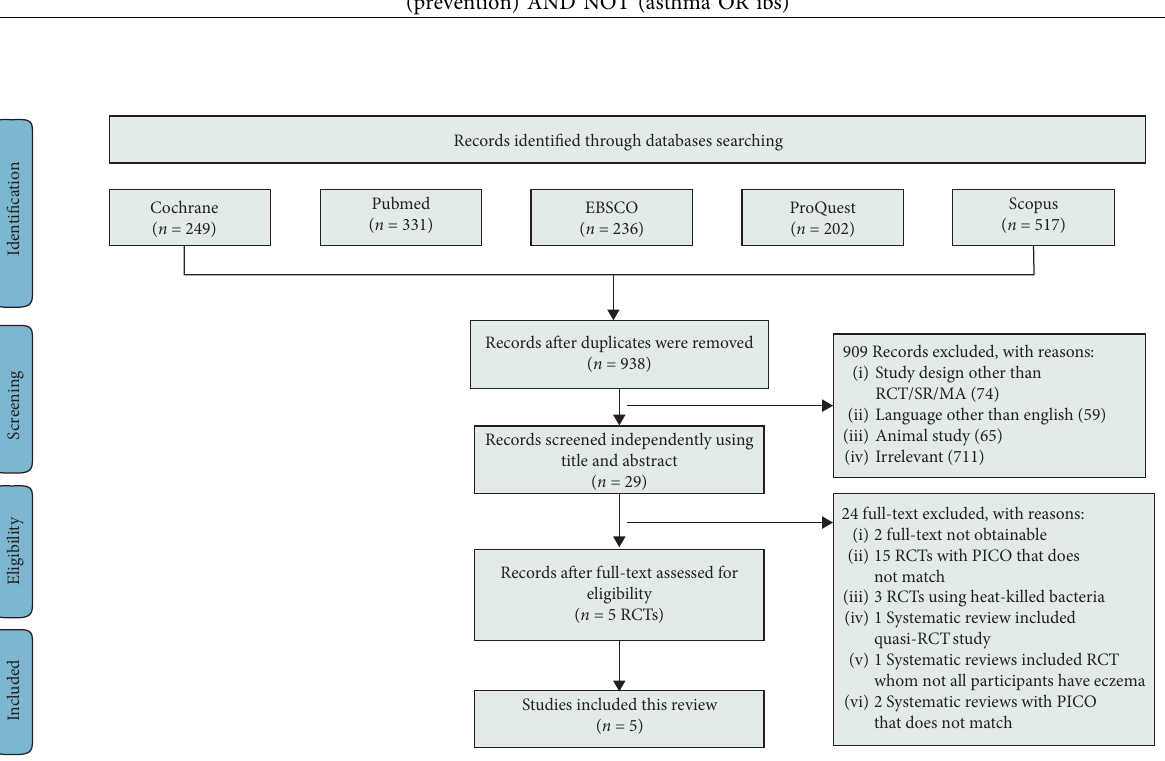
Figure 1: PRISMA flowchart describing the steps of study selection.